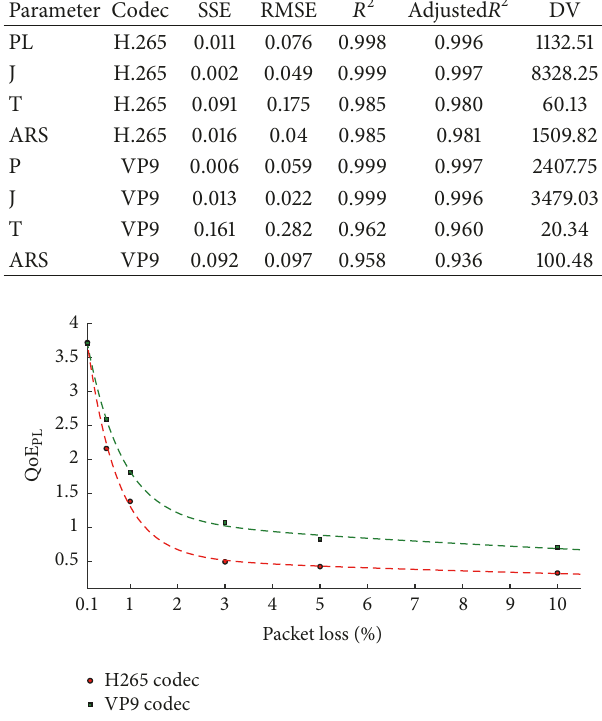
(from subjective PL